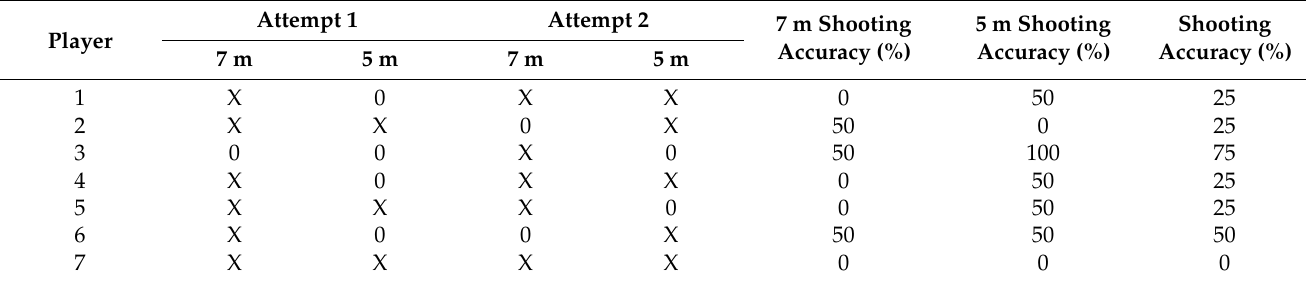
Table 2. Results of the attempted shots from 7 and 5 m during the two attempts. X represents the failed attempt and 0 represents the successful